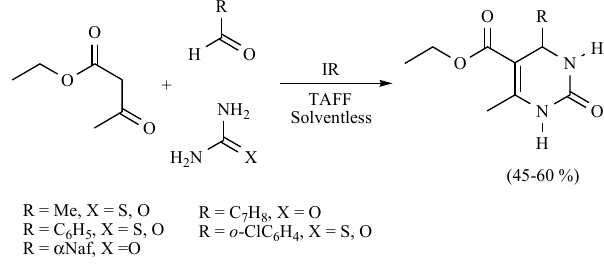
Scheme 14. Synthesis of Biginelli esters.